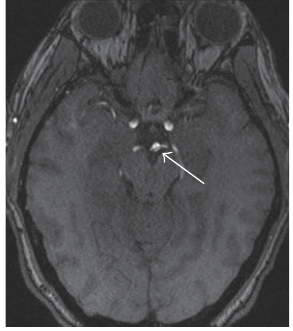
Figure 2: 3D Time of Flight MRA source images demonstrate a linear filling defect (white arrow) in the distal basilar artery with extension into the right posterior cerebral artery (PCA) P1 segment. Additional images (not shown) demonstrated this defect also extending into the left PCA P1 segment.